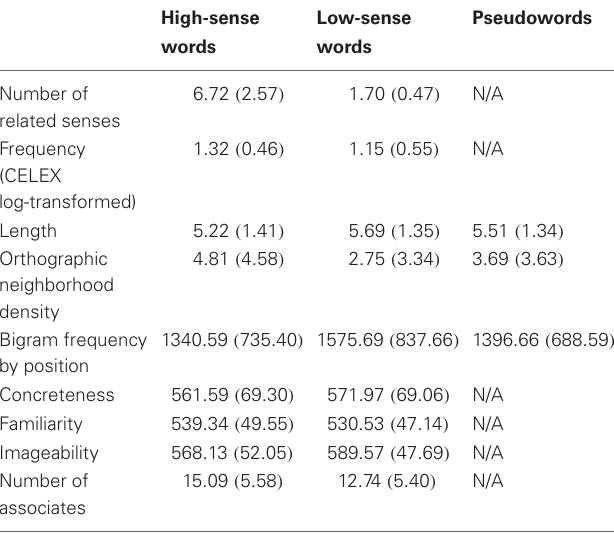
Table 1 | Characteristics of experimental stimuli: mean (standard